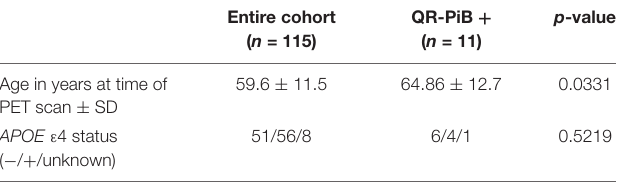
TABLE 6 | Entire test cohort vs. QR-PiB positive.